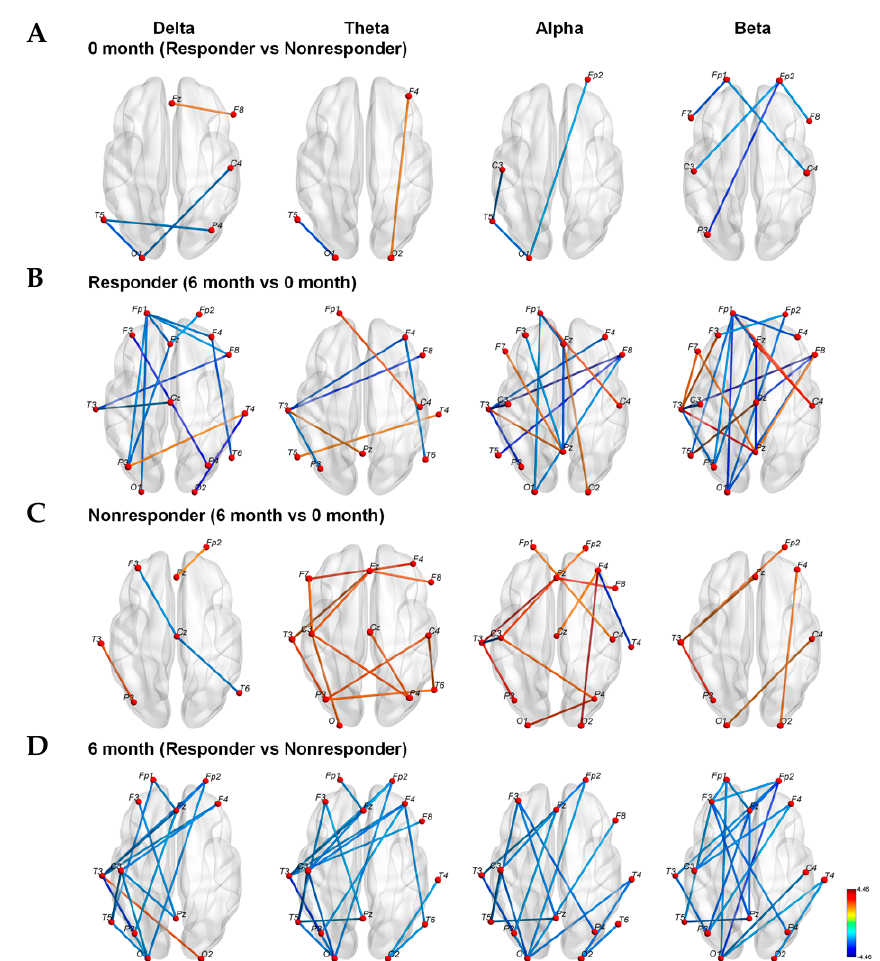
Figure 1. Network-based statistics between responders and non-responders or between before KDT and after six months of KDT in the delta, theta, alpha, and beta frequency bands; ( A ) The comparison of networks between responders and non-responders before starting KDT; ( B ) The networks of responders after 6 months’ KDT compared to that before KDT; ( C ) The comparison of 6 months to before usage in non-responders; ( D ) The responders’ networks compared to non-responders’ after 6 months of KDT. (KDT: ketogenic diet therapy.)